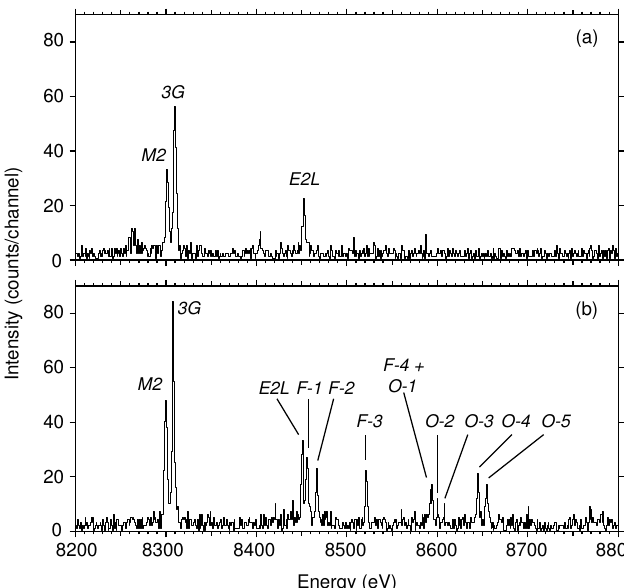
Figure 1. X-ray emission of highly charged tungsten ions at an electron beam energy of ( a ) 15 keV and ( b ) 21 keV. The strongest lines are from neon-like W 64+ and are labeled M 2 , 3 G and E 2 L . Lines from fluorine-like W 65+ and oxygen-like W 66+ are labeled by F and O , respectively.